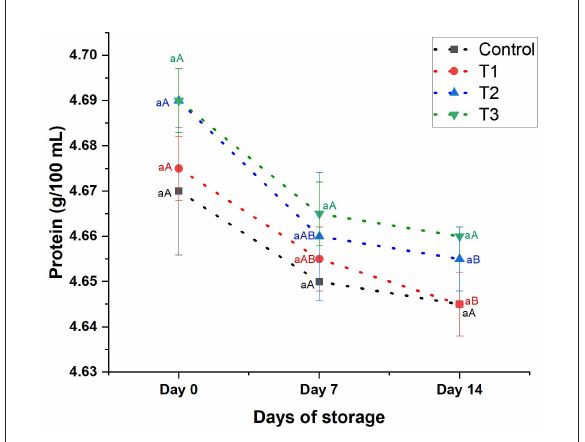
FIGURE4 Protein content (g/100mL) of control beverage and beverages enriched with beetroot peel extracts at different concentrations. Means with different lowercase letters (a–d) on the same storage day are statistically different ( p < 0.05). Means with different uppercase letters (A–C) for each treatment during the different storage days are statistically different ( p <